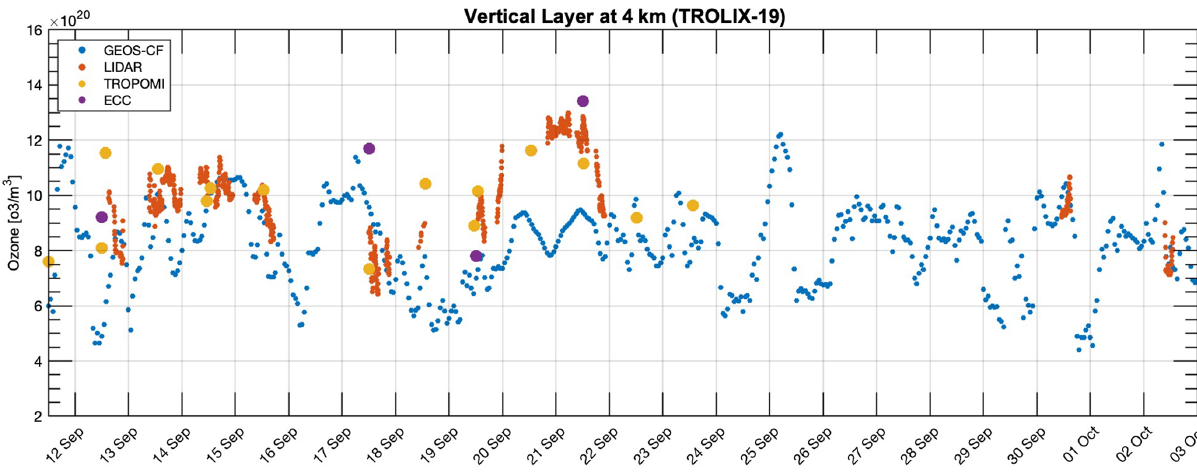
Figure 3. Ozone number density values for the TROPOZ lidar, GEOS-CF mode, TROPOMI and electro-chemical cell (ECC) ozonesondes at the 4km layers. The layer was calculated to match the closest representative vertical layer of the GEOS-CF for consistent intercomparison. Data are averaged in a 500m layer from 3.94 to 4.44kma.g.l.